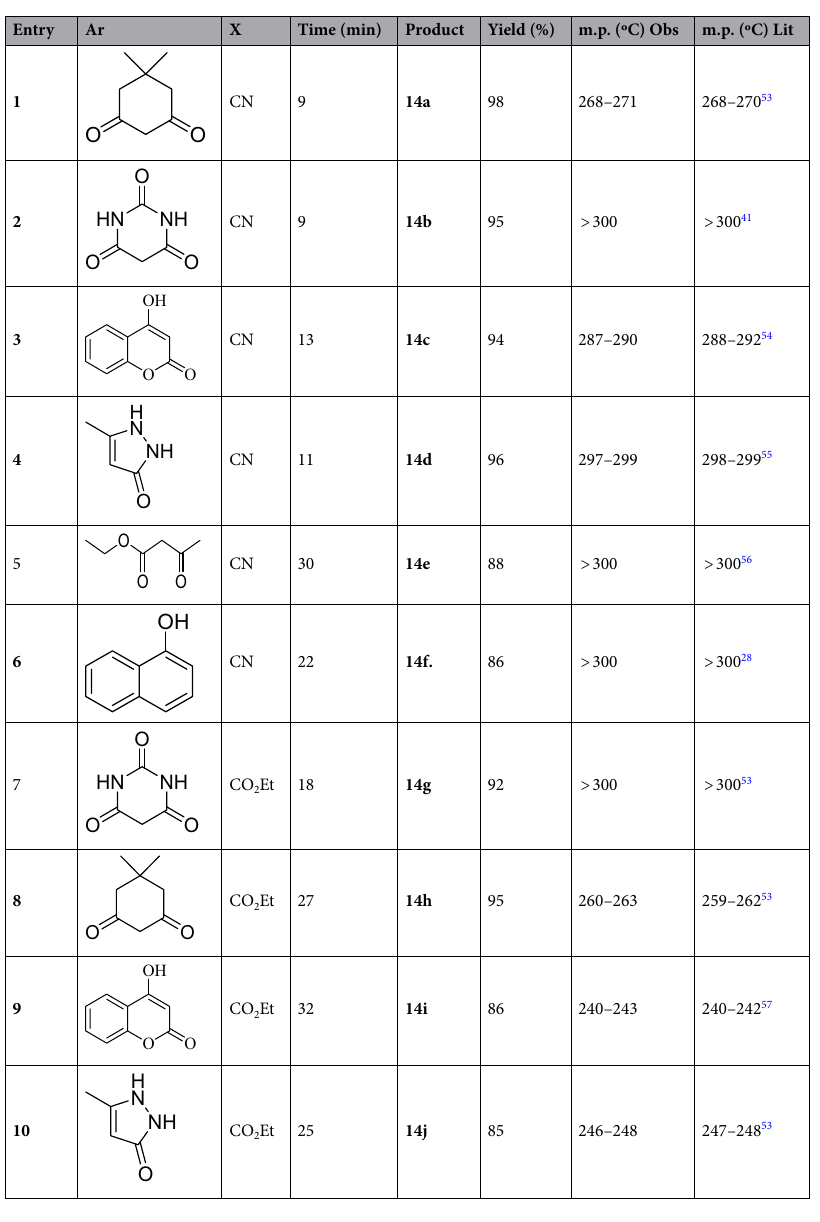
Table 3. Synthesis of 14a-j derivatives in the presence of biochar/Fe 3 O 4 /PVIm/Ag.